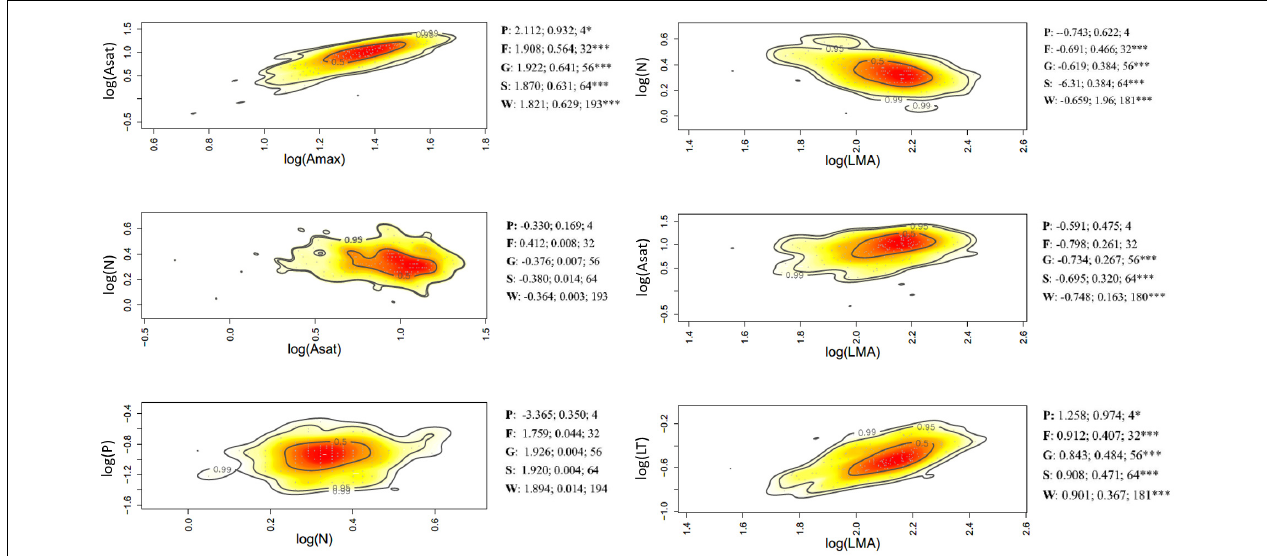
FIGURE 5 | Bivariate trait relationships at the forest-savanna gradient expressed through kernel density plots for selected trait bivariate relationships, and results of SMA regressions (slope, r2, degrees of freedom) for trait values community weighted at the tree level (W), species (S); genus (G); family (F), and plot (P). Stars *** represent significant after Holm correction. Full results of SMA regression analyses for the whole suite of traits is presented in Supplementary Table S6 .